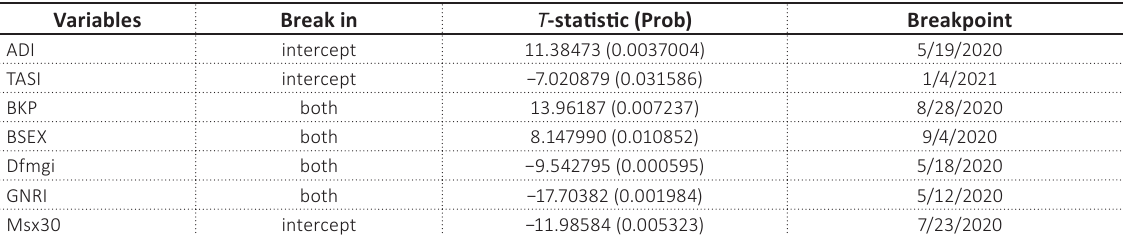
Table 4. Zivot and Andrews (1992) unit root